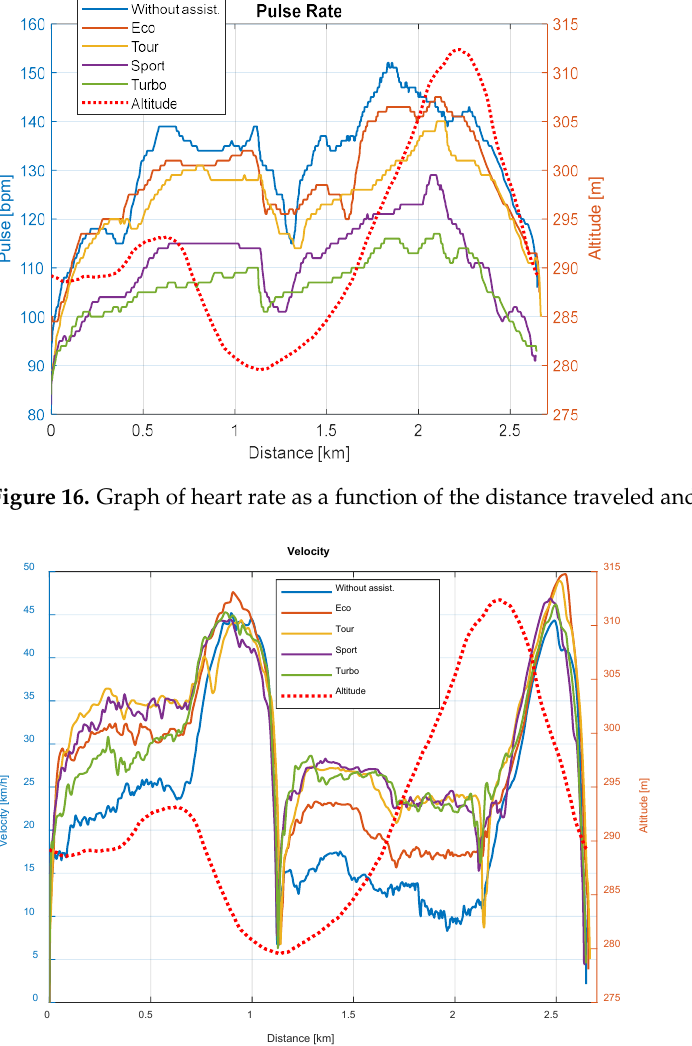
Figure 17. Distance travel speeds depending on the assist mode.